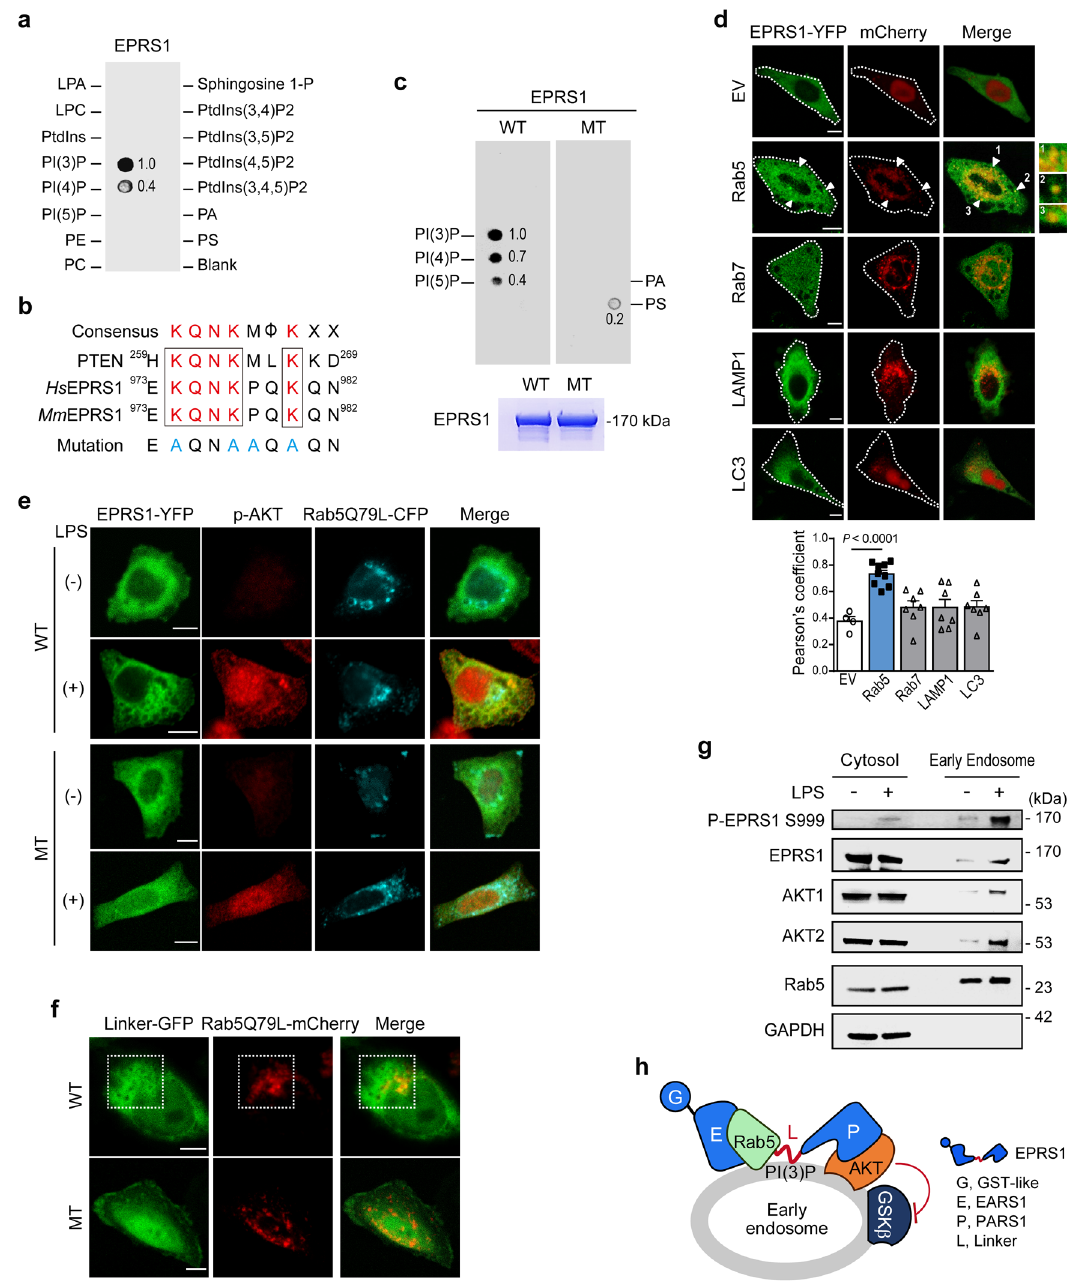
Fig. 4 | EPRS1 binds speci fi cally to PI(3)P and Rab5 to coordinate early endo- somal anti-in fl ammatory AKT signaling. a PIP strips precoated with indicated lipids were incubated with puri fi ed Strep-EPRS1 and probed with an anti-Strep antibody. b Sequence alignment of EPRS1 with PTEN to show the PI(3)P-binding consensus motif. The last row shows mutations engineered to neutralize early endosomal localization. c PIP strips were incubated with puri fi ed Strep-EPRS1 WT or its mutant (MT) and probed with an anti-Strep antibody for the same exposure time. d HeLa cells were transfectedwith a mCherry-taggedEV, Rab5, Rab7, LAMP1, orLC3(red),incombinationwithEPRS1-YFP(green).Confocalmicroscopyanalysis showingcolocalizationofEPRS1andorganelle-speci fi cproteinsintransfectedcells following LPS (500ng/ml) stimulation for 30min. White arrowheads indicate colocalized early endosomes, and the magni fi ed images are displayed in the right panel. The colocalization index of EPRS1 and speci fi c organelle markers was quanti fi ed using Pearson ’ s correlation (bottom, n =5 cells for EV, n =9 cells for Rab5, n =7 cells for other markers). Error bars indicate the mean±SEM. Data were analyzed using Student ’ s two-tailed t -test. e HeLa cells were transfected with YFP-